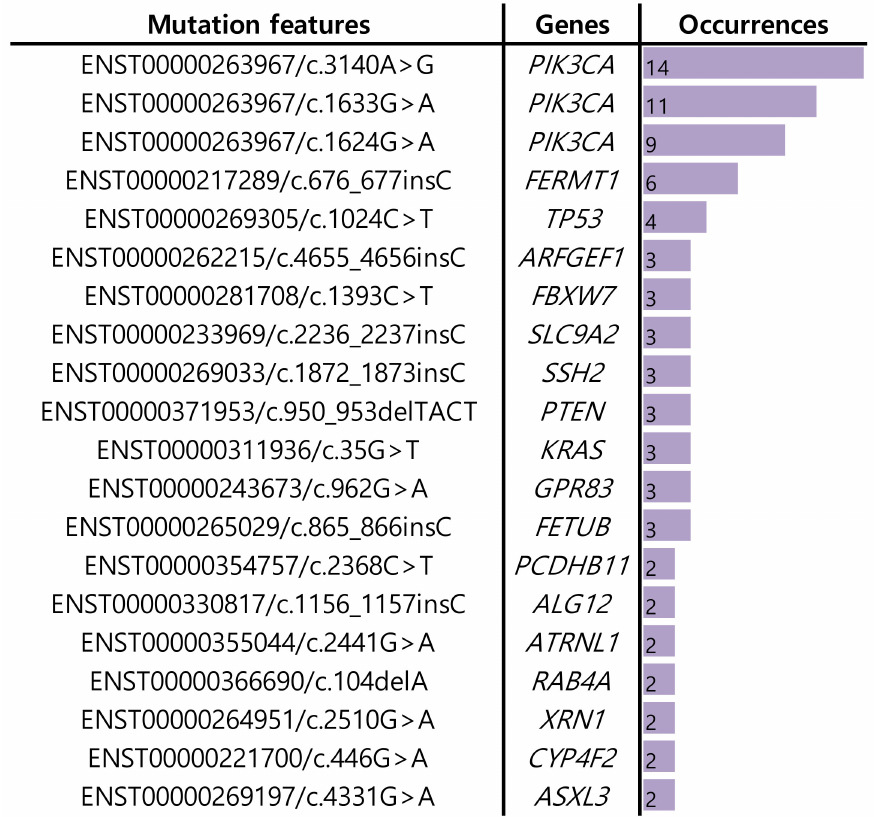
Figure 5. Important features of GoogLeNet, by LIME, in the TCGA-BRCA dataset. Column ‘occur- rences’ in a given mutation feature indicates the frequency observed in the 322 patients by